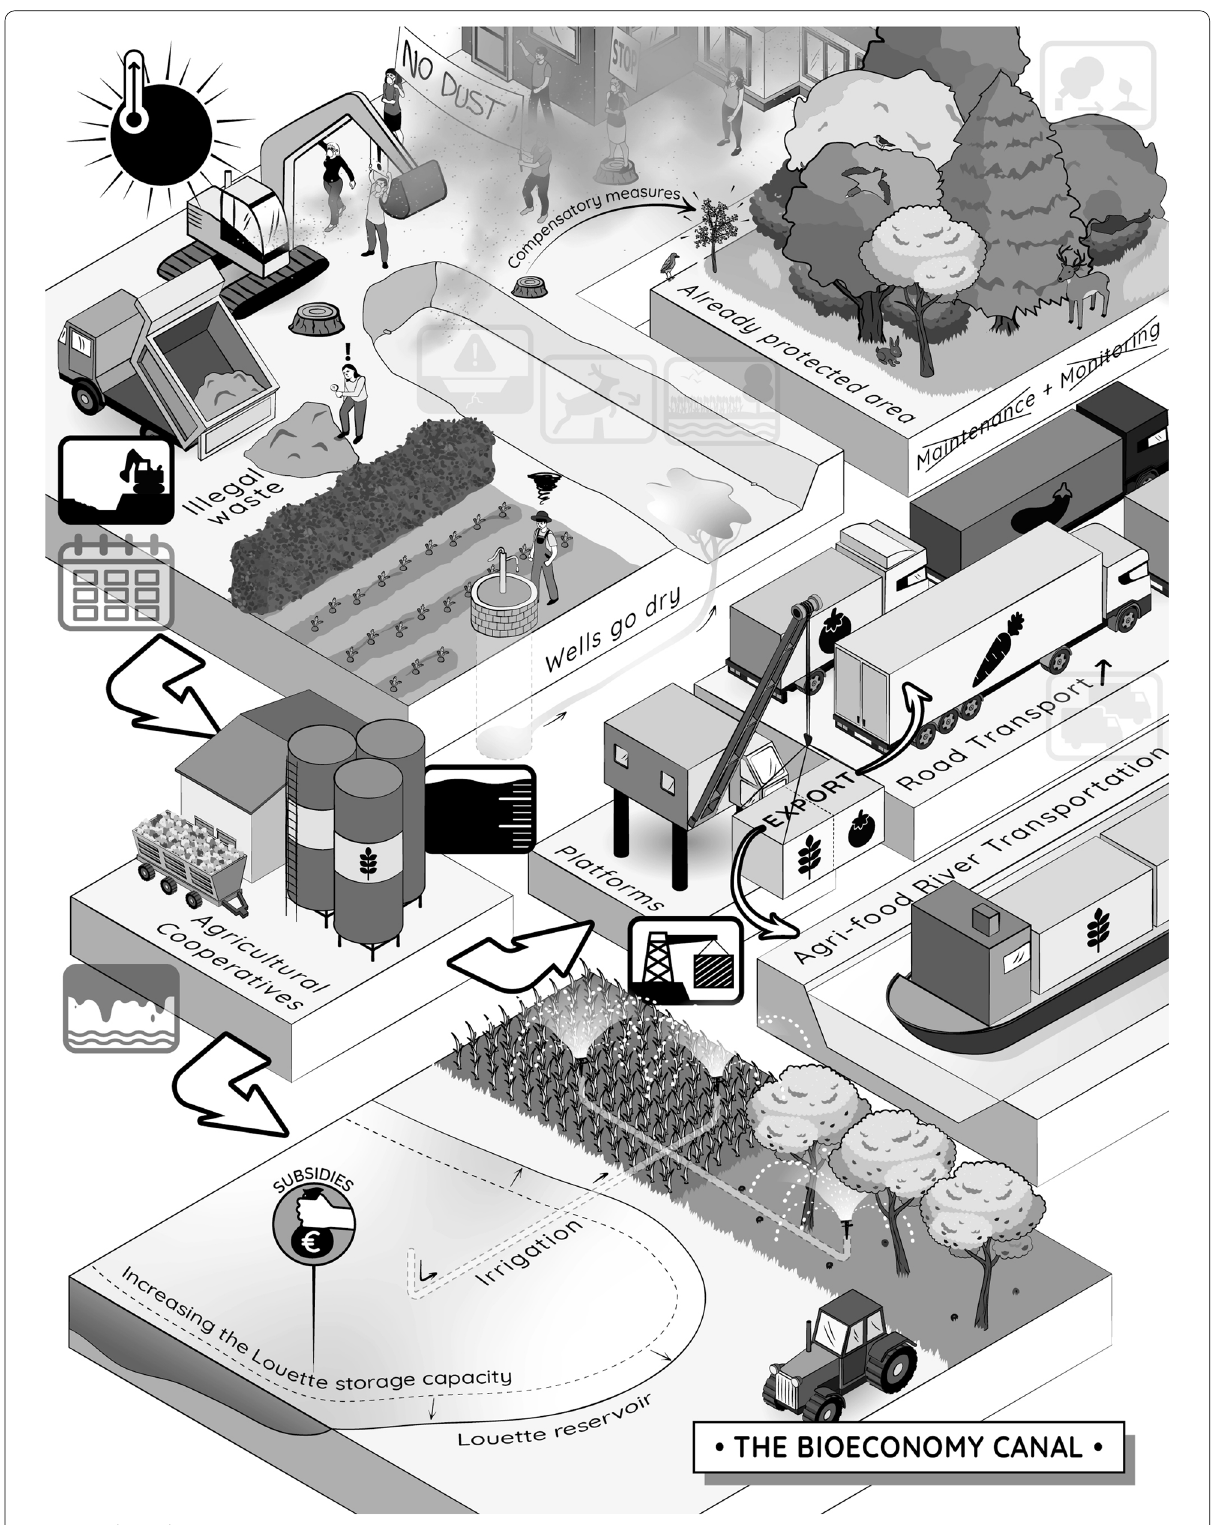
Fig. 4 (See legend on previous